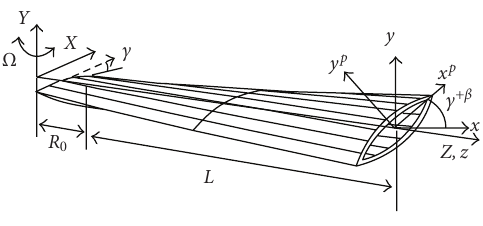
Figure 3: Geometry of the pretwisted